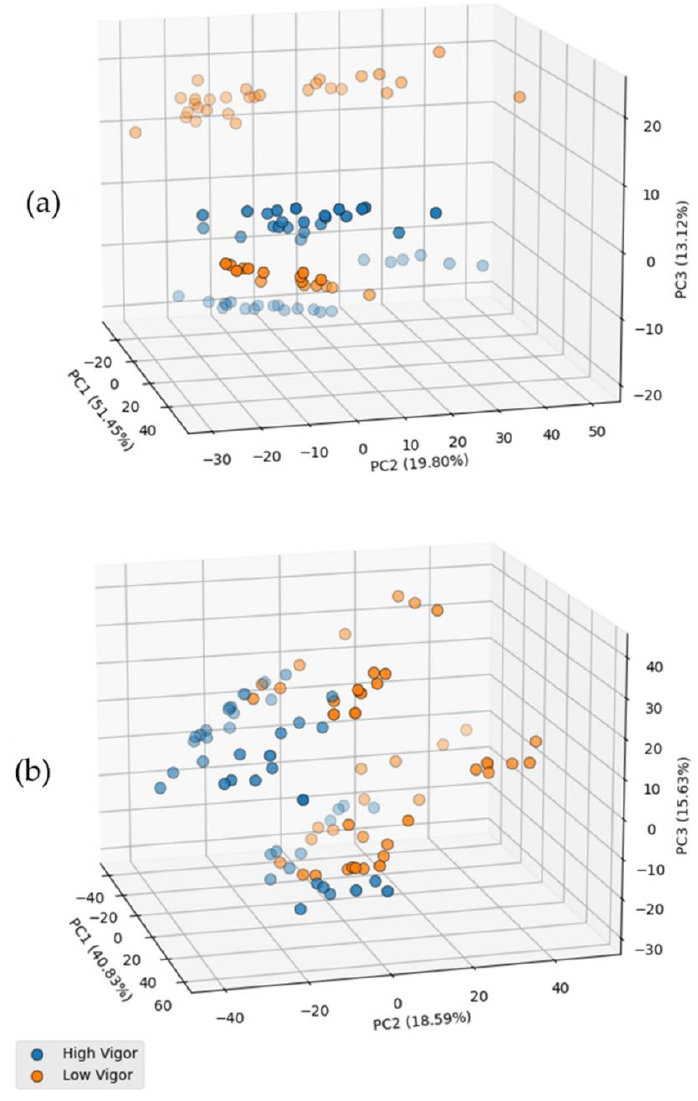
Figure 2. Score plots of the first three PCs: ( a ) UV region and ( b ) VIS